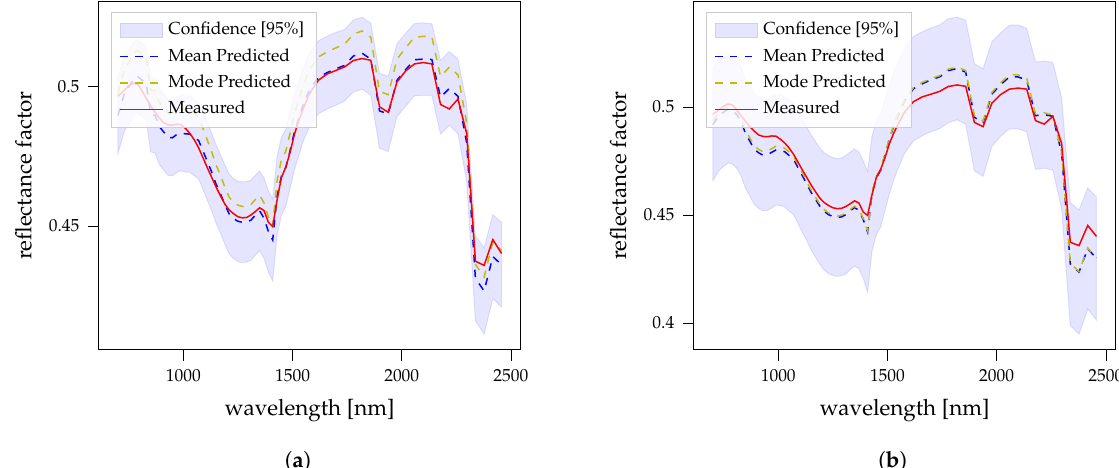
Figure 16. Confidence for mix 0 of the fresh laboratory mixtures. Uncertainty of the spectrum slightly increases with the introduction of a prior on the TiO 2 abundance. ( a ) Without prior; ( b ) TiO 2 prior.